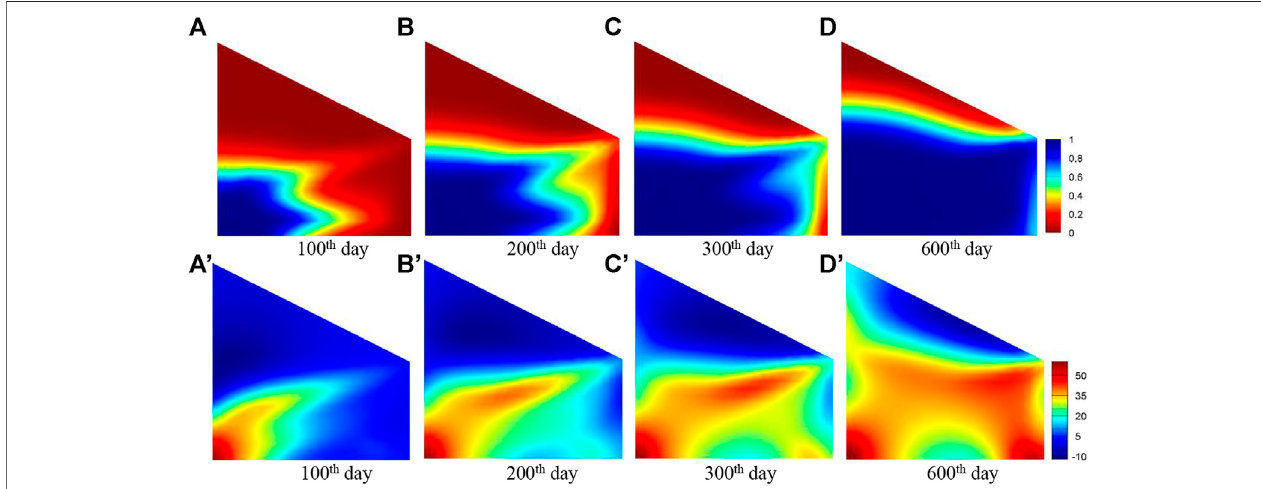
FIGURE 10 | The ferro fl uid saturation and magnetic anomaly distribution at different time. (A – D) respectively show the ferro fl uid saturation at 100th, 200th, 300th, 600th day; (A 9 – D 9 ) respectively show the magnetic anomaly at 100th, 200th, 300th, 600th day.